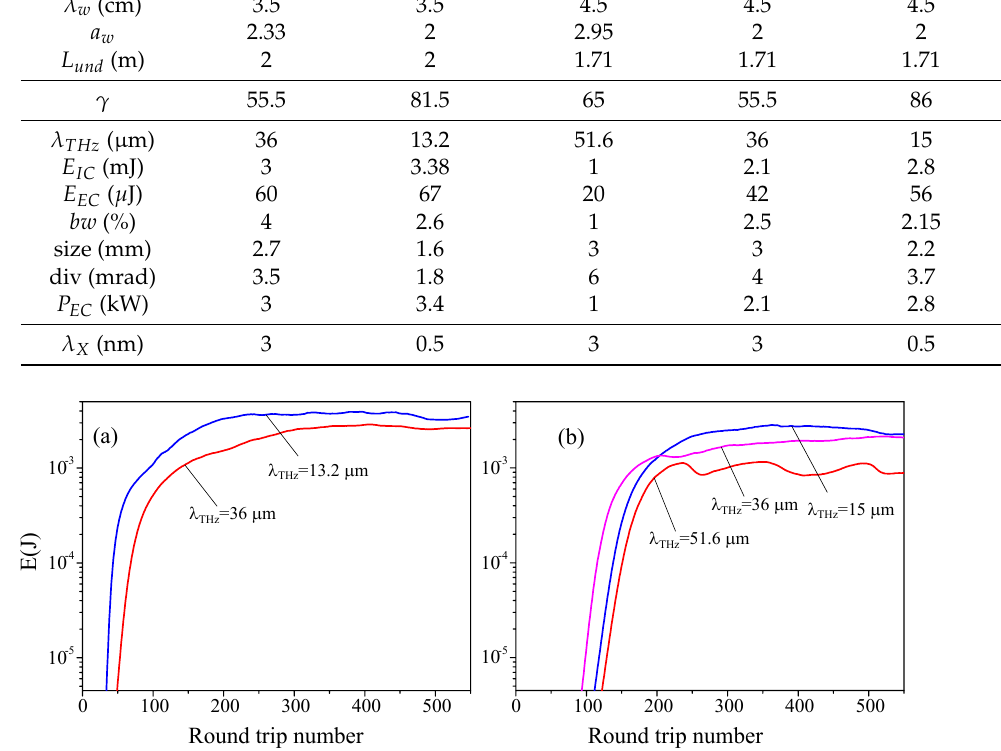
Figure 7. Intra-cavity radiation energy growth E(J) vs. a number of shots N. Window ( a ): undulator period λ w = 3.5 cm; red curve: γ = 55.5, λ = 36 µ m; blue curve: γ = 81.5 λ = 13.2 µ m. Window ( b ): undulator period λ w = 4.5 cm; red curve: γ = 65, λ = 51.6 µ m; magenta curve: γ = 55.5, λ = 36 µ m; blue curve: γ = 86, λ = 15 µ